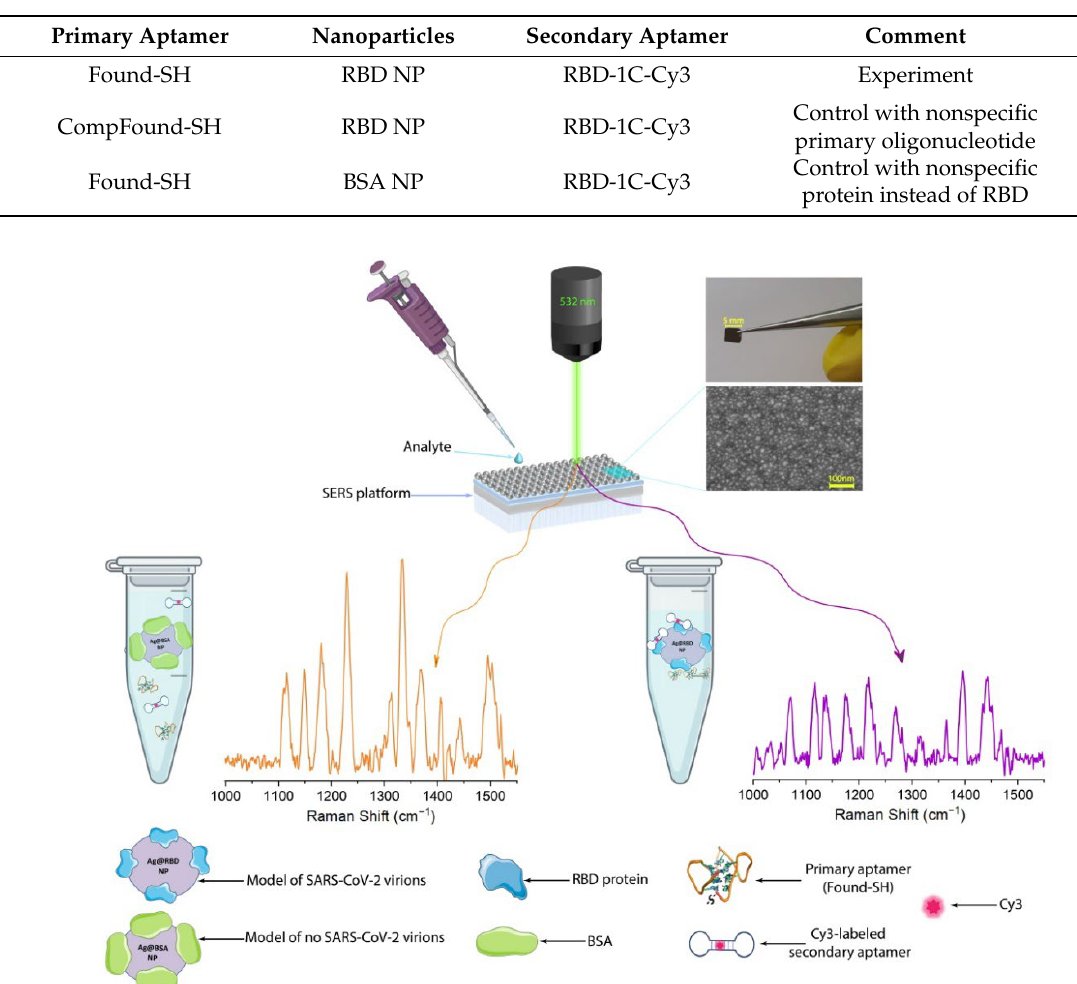
Figure 1. Scheme of the developed indicator system for SARS-CoV-2 virions’ detection using the SERS approach.